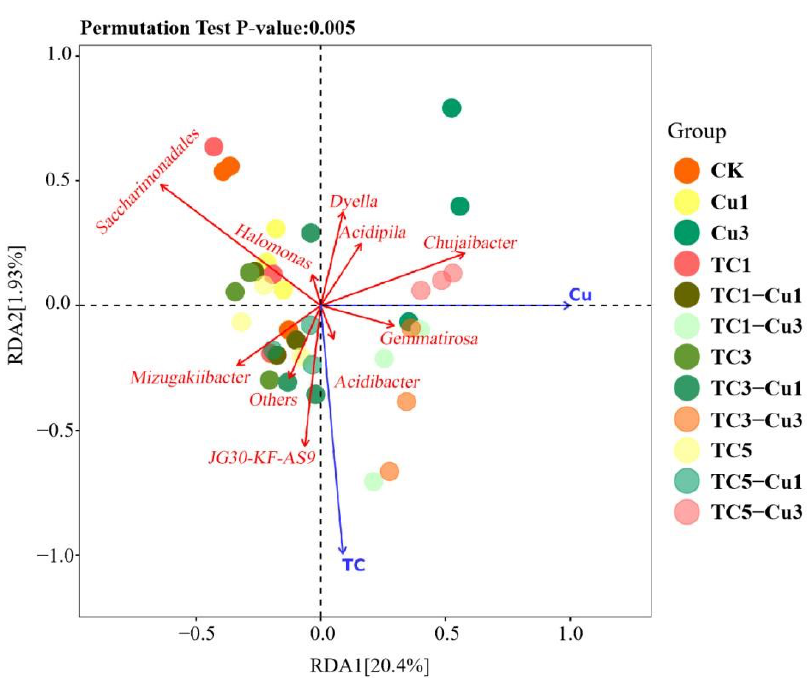
Figure 7. RDA ordination plot showing the relationship between the bacteria community structure and the environmental factors. (Blue arrows represent environmental factors; Red arrows represent species names.).